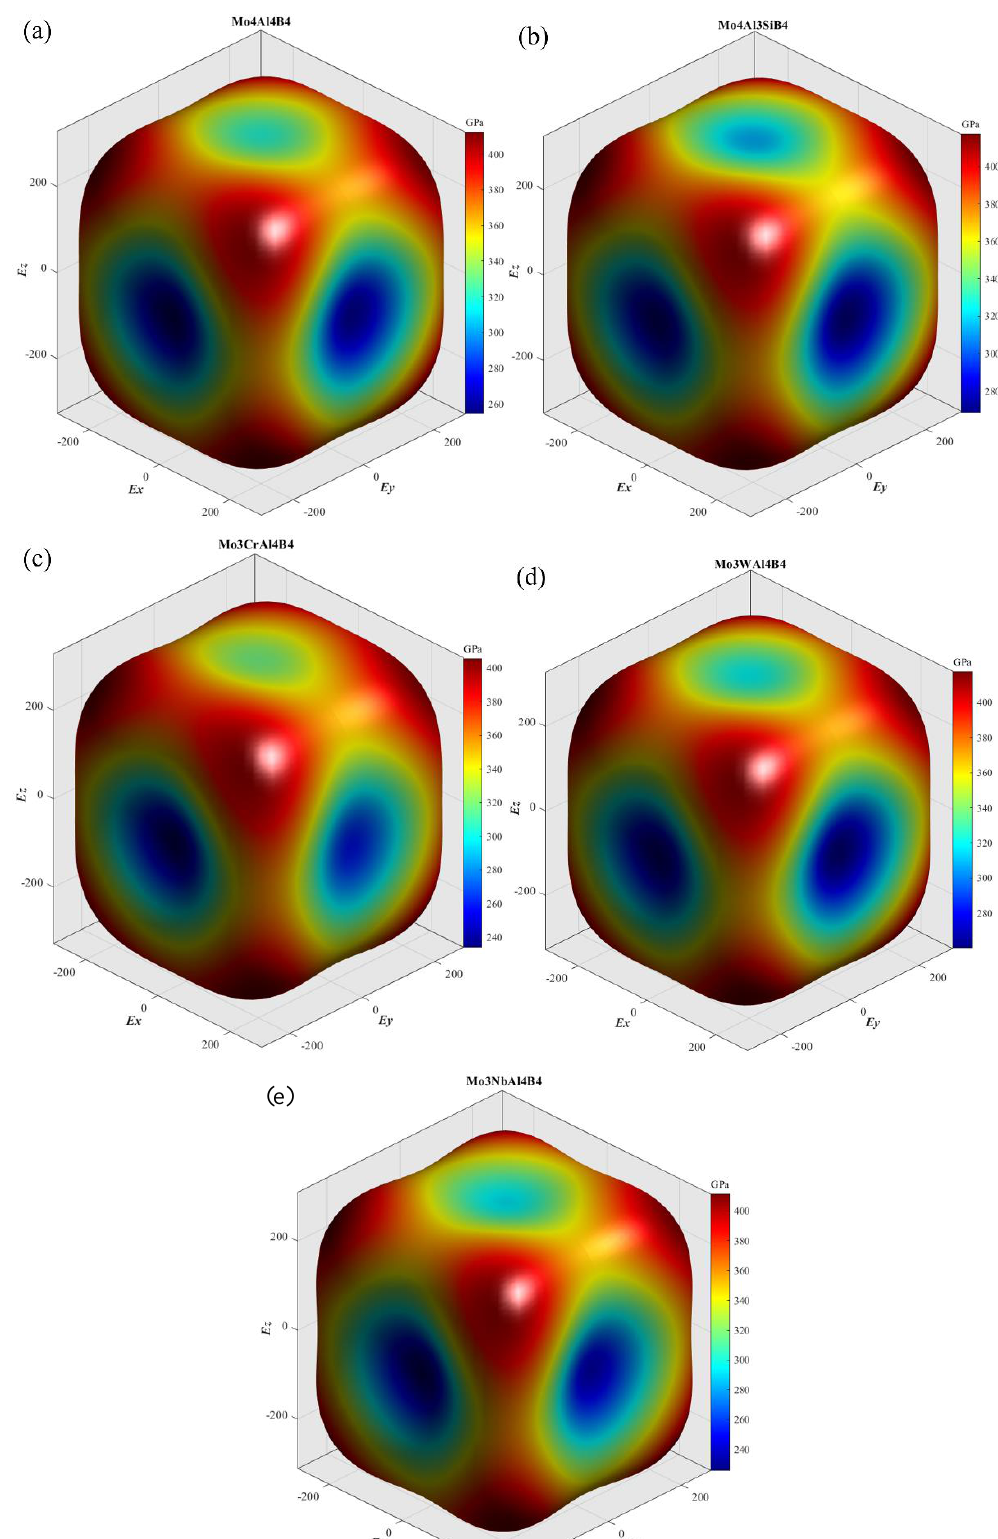
Figure 3. The spatial surface contours of Young’s modulus: ( a ) Mo 4 Al 4 B 4 ; ( b ) Mo 4 Al 3 SiB 4 ; ( c ) Mo 3 CrAl 4 B 4 ; ( d ) Mo 3 WAl 4 B 4 ; ( e ) Mo 3 NbAl 4 B 4